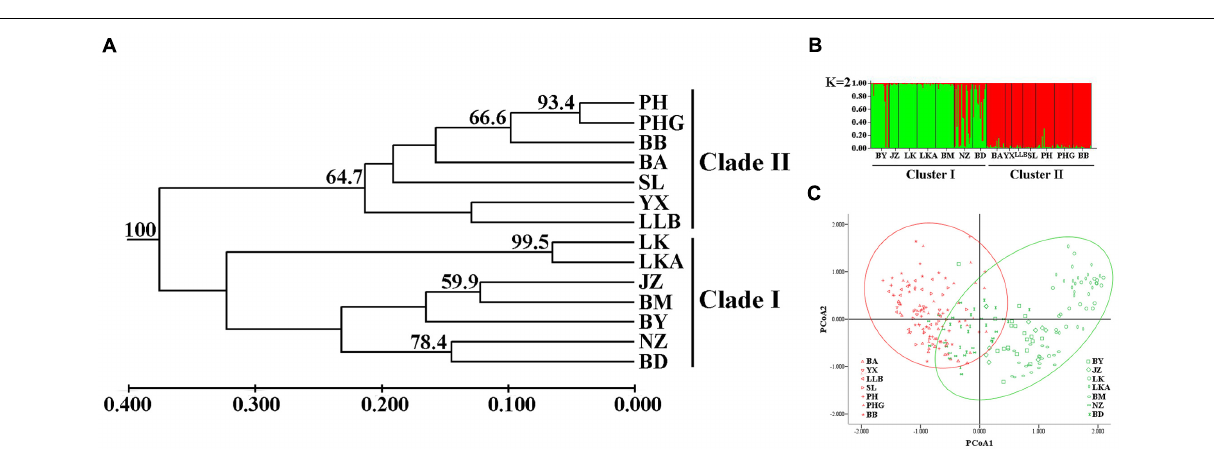
FIGURE 6 | (A) An unweighted pair-group method with arithmetic averages (UPGMA) phenogram (numbers on branches indicate bootstrap values from 5,000 replicates), (B) Bayesian inference using STRUCTURE ( K = 2) and (C) Principal coordinates analysis (PCoA) of SSR phenotype from 14 populations of 238 individuals of C. segmentifida